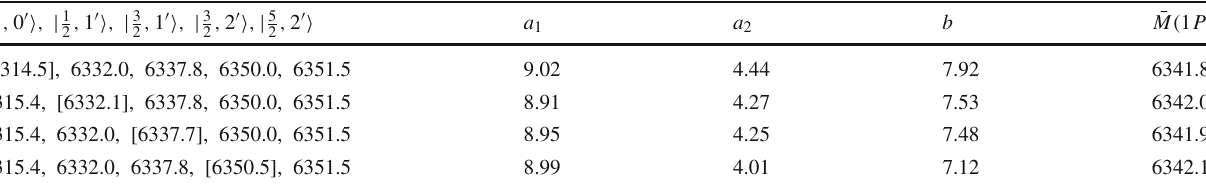
Table 5 Parameters and masses(all in MeV) for the excited Ω b when one of four observed masses was removed from the mass inputs. The removed one (enclosed by square bracket) is reproduced by Eq. (7) approximately